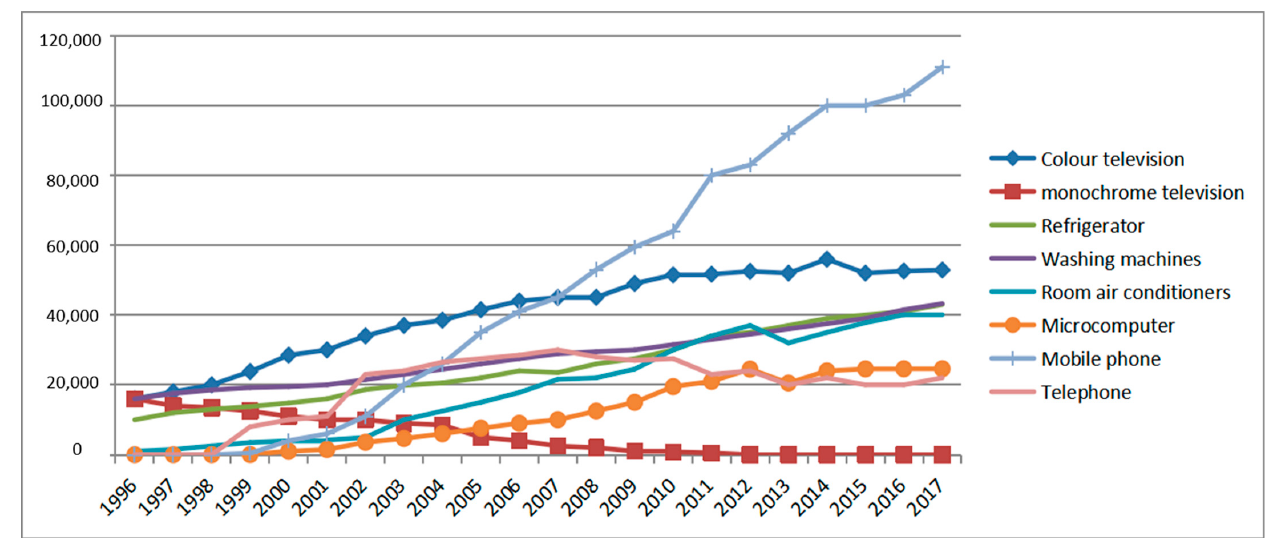
Figure 6. Household output of electrical and electronic products in China (10,000 units).